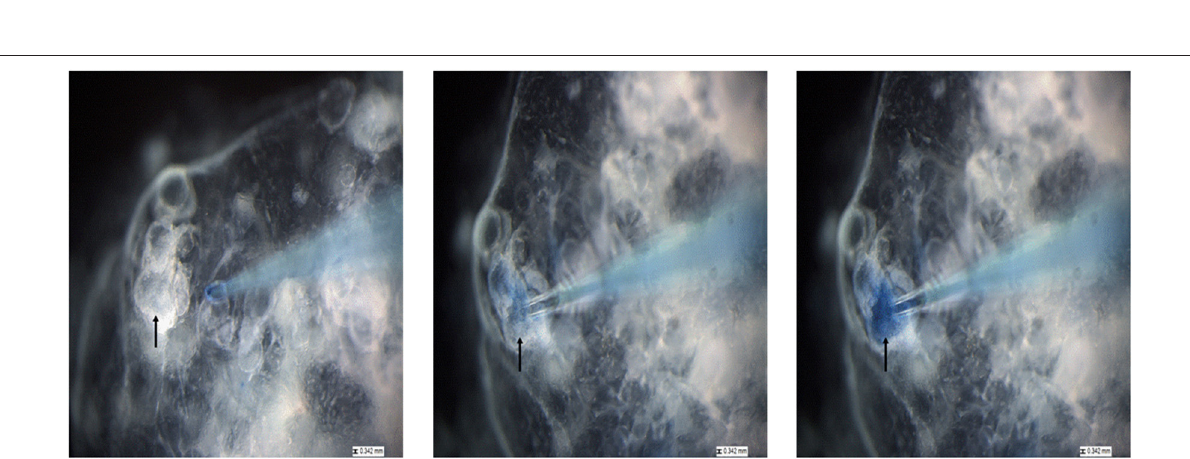
FIGURE 5 | The process of injecting lung organoids with P. murina stained with trypan blue. Black arrow is pointing at the organoid that is injected with P. murina. After about 2 weeks of growth organoids are injected with P. murina . From left to right is a depiction of the process of injecting an organoid with P. murina stained with trypan blue. Scale bars for the images are